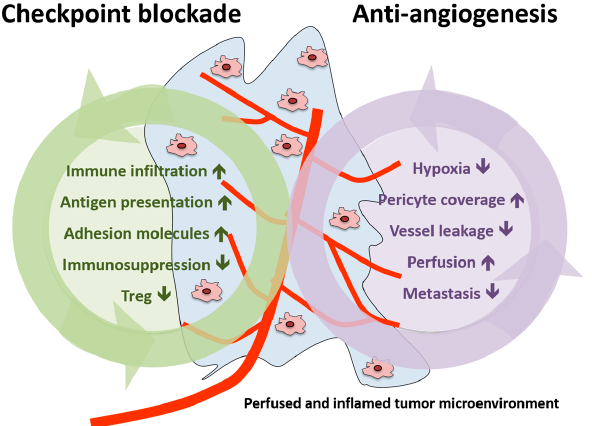
Figure 3. Schematic presentation of the effects of immune checkpoint blockade and antiangiogenesis in both the tumor and the tumor microenvironment. Treg, regulatory T cell.